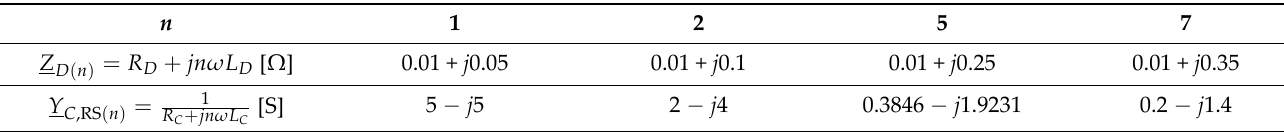
Figure 11. A non-linear single-phase receiver connected to a three-phase power source. Table 1. Impedances and admittances of C and D The calculation results are presented in Tables 1 and 2.